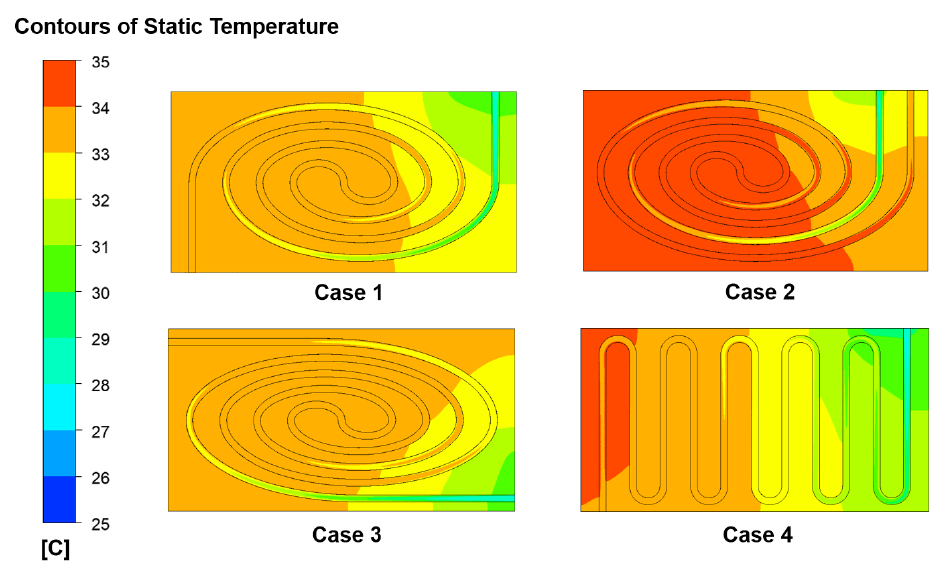
Figure 7. Temperature distribution in the four LCPs: Case 1 to Case 4.